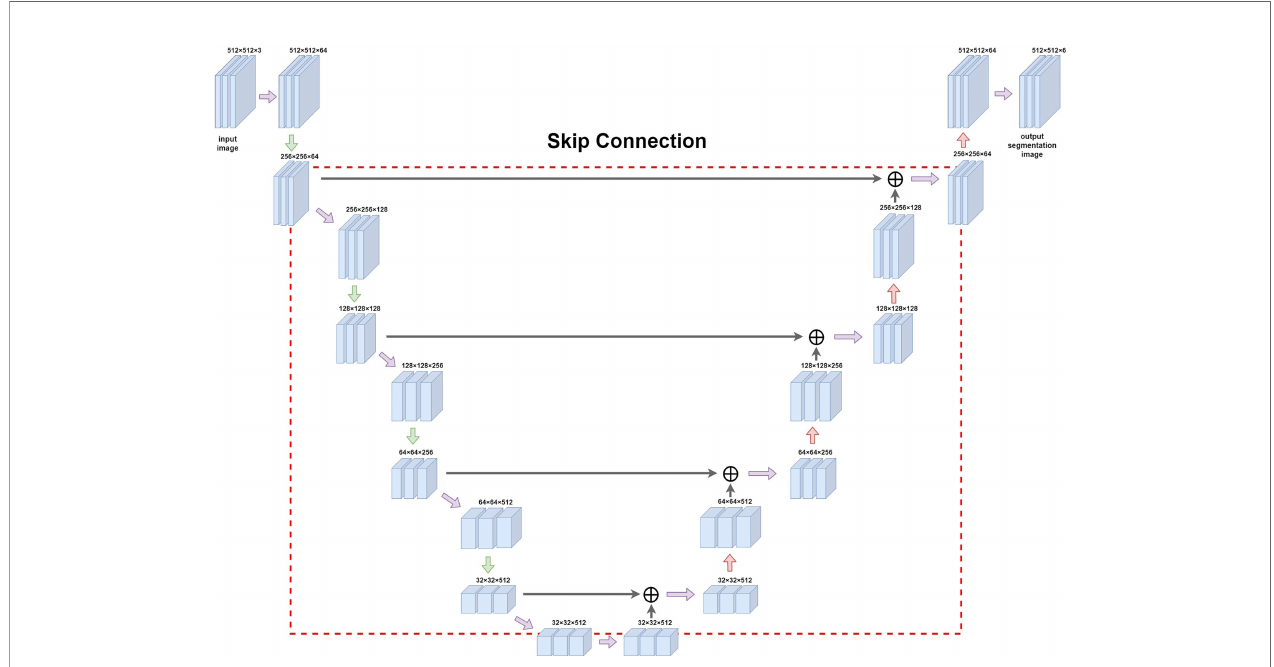
FIGURE 3 | Diagram of Unet network construction. The red box (dashed line) in the fi gure is the jump structure of u-shaped structure, which can be used to splice and fuse the feature graphs on the left and right sides to deeply fuse the semantic information before and after